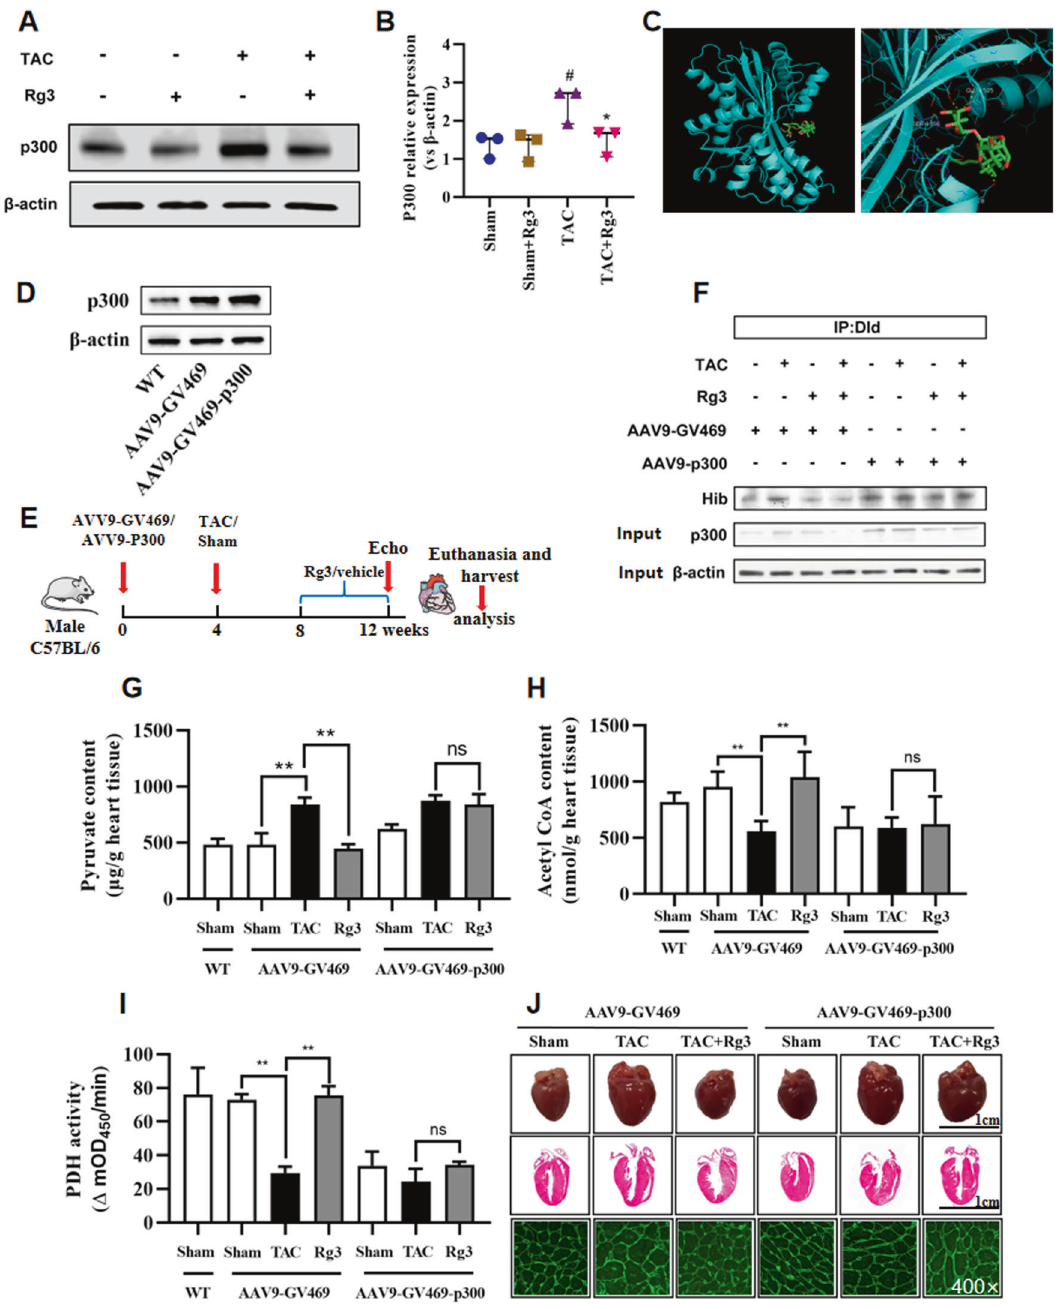
Fig. 6 Rg3 Downregulated DLD 2-Hydroxyisobutyrylation and Regulated Pyruvate Metabolism by P300. A , B Representative digital western blots for P300 and β -actin, and corresponding quantitative data, n = 3 for each group. C Molecular docking showing Rg3 in the binding site of P300. D Representative digital western blots for P300 and β -actin, n = 3 for each group. E Schedule of animal treatments. AVV9- GV469 and AVV9-GV469-P300 were injected intracardiacally. TAC operation was performed four weeks later. Rg3 or vehicle was administered to TAC mice the fourth week after surgery and maintained by one administration per day for 4 weeks. F Heart homogenates were immunoprecipitated with anti-DLD agarose beads, and probed with anti-2-hydroxyisobutyryl-lysine, anti-DLD, and anti- β -actin antibody. The representative immnoublots were presented, n = 3 for each group. G , H The contents of pyruvate and acetyl-CoA in heart tissue, n = 3 for each group. I The activity of pyruvate dehydrogenase in heart tissue, n = 3 for each group. J Representative images showing gross cardiac morphology of mice in each group. HE staining of longitudinal heart. WGA staining, n = 5 – 8 for each group. The data were analyzed using Kruskal – Wallis test and were expressed as means ± SD, # p < 0.05, ## p < 0.01 versus Sham group, * p < 0.05, ** p < 0.01 versus TAC